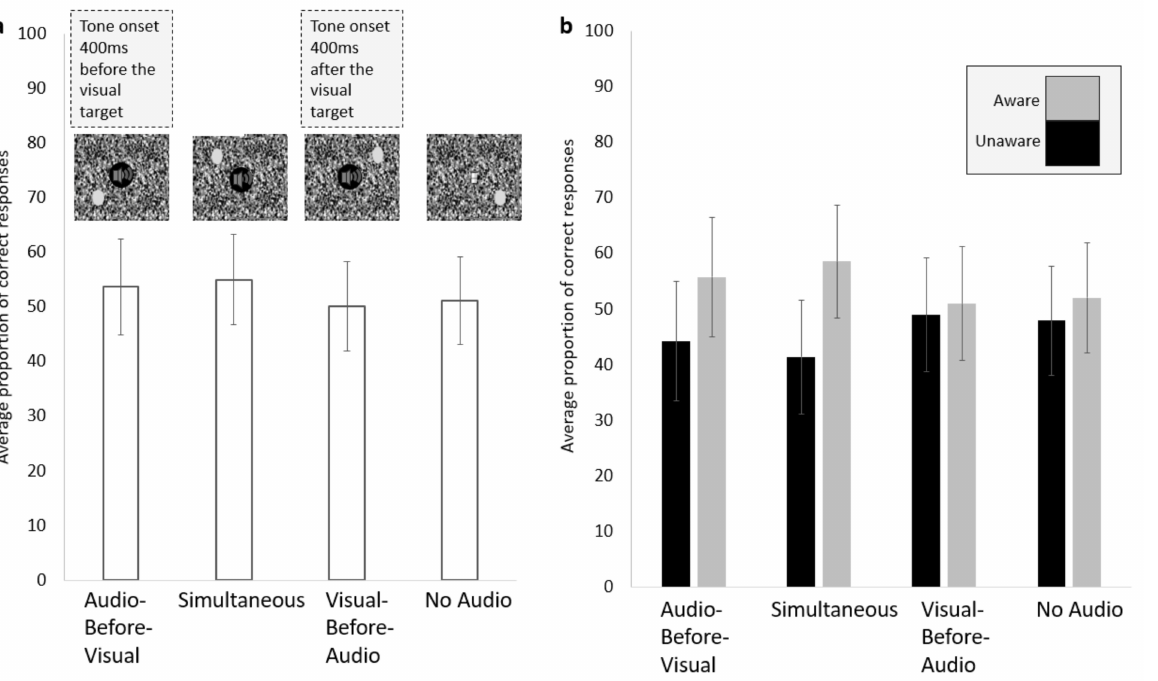
Figure 5. The proportion of correct trials (aware and unaware) for each condition ( a ) and the proportion of aware (grey) and unaware (black) of all the correct trials ( b ). Error bars represent the standard error of the